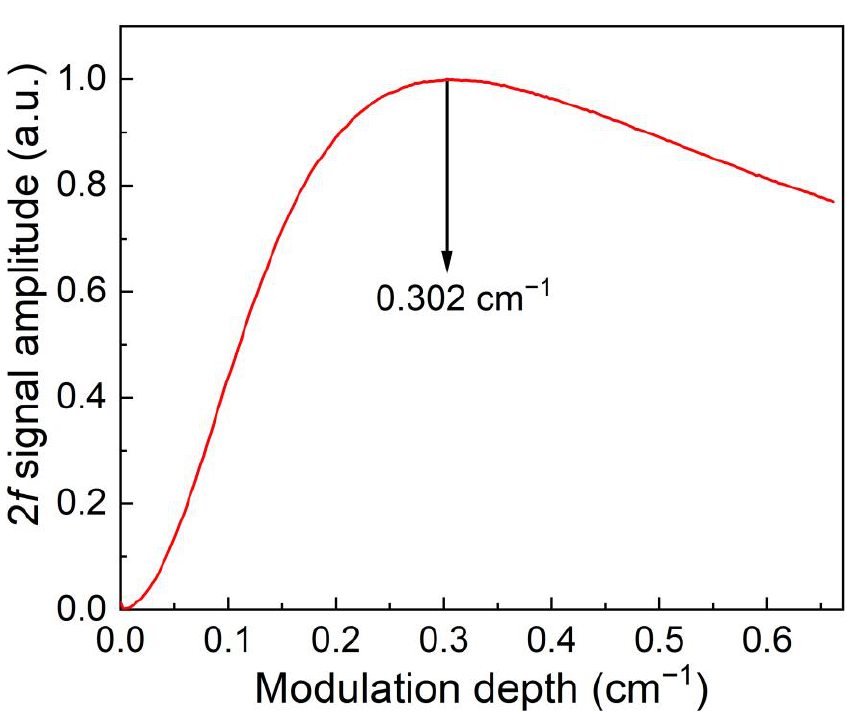
Figure 7. The 2 f signal versus diode laser wavelength modulation depth for CH 4 -QEPAS sensor with 3D-printed ADU.